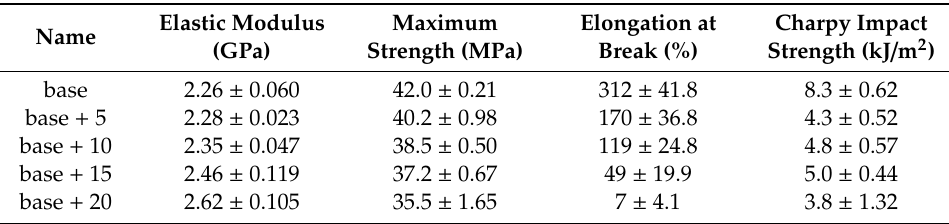
Table 3. Mechanical properties of the